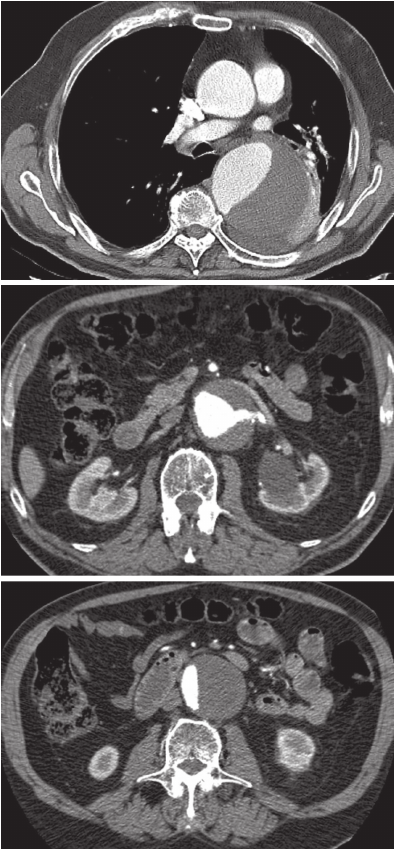
Figure 1: Computed tomography sections at the level of the descending aorta (upper panel), at the level of the left renal ostium (middle panel), and at the level of the infrarenal aorta (lower panel).